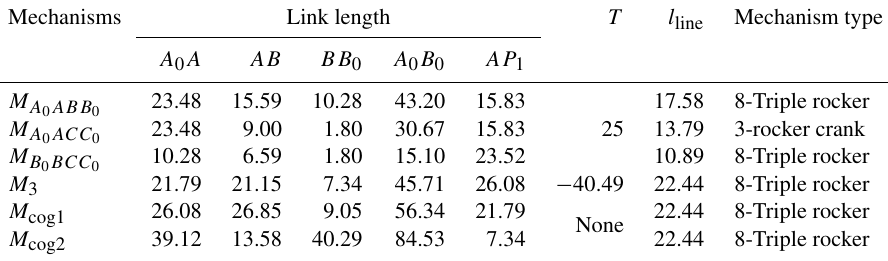
Table 2. Mechanism parameters.